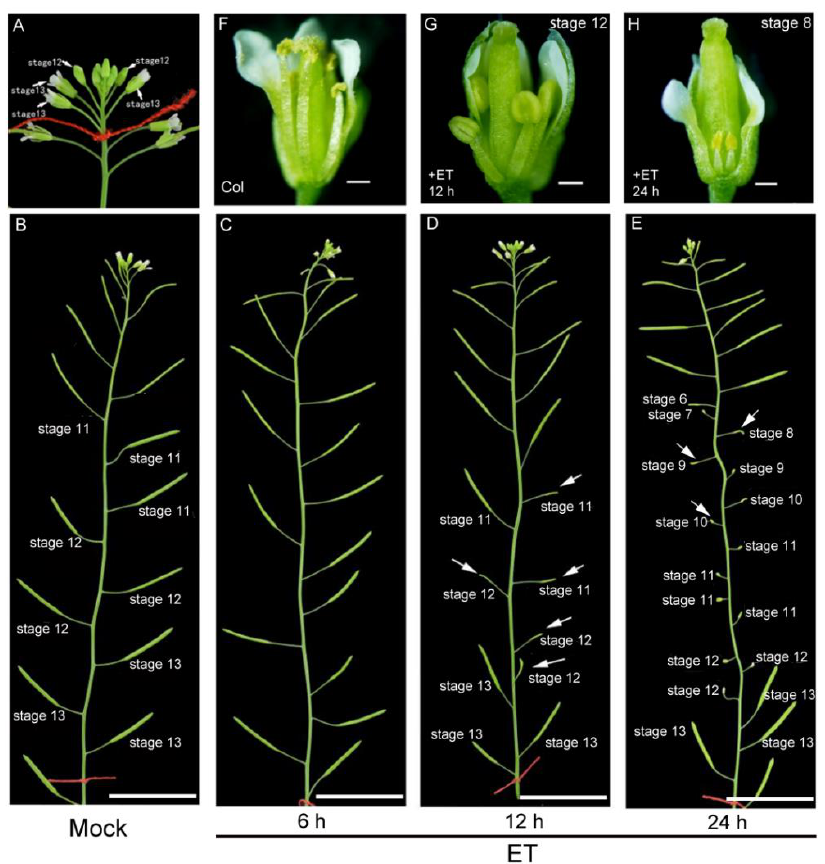
Figure 1. The fertility was disturbed after exogenous ethylene treatment. ( A ) Inflorescence before ethylene treatment. Note that the start position of inflorescence (flower with anthers at stage 13) was marked with a red line so as to observe the elongation of siliques after 14 days. ( B – E ) Inflorescence of Col without ET treatment ( B ), with ethylene (100 µL L −1 ) treatment for 6 h ( C ), 12 h ( D ), and 24 h ( E ). After ET treatment, these plants grew for 14 days under normal conditions. Arrows indicate the closed buds or short siliques without seeds. The developmental stage of anthers in each bud before ethylene treatment is marked next to the corresponding siliques or flower buds. Bars = 2 cm in B–E. ( F ) Col flower. Bar = 1.0 mm. ( G , H ) Col flower after ethylene (100 µL L −1 ) treatment for 12 h ( G ) and 24 h ( H ). Note that filaments are shortened after 12 h or 24 h ethylene treatment, and the development of the anther of stage 8 is abnormal after 24 h ethylene treatment. Bars = 1.0 mm in ( G , H ).